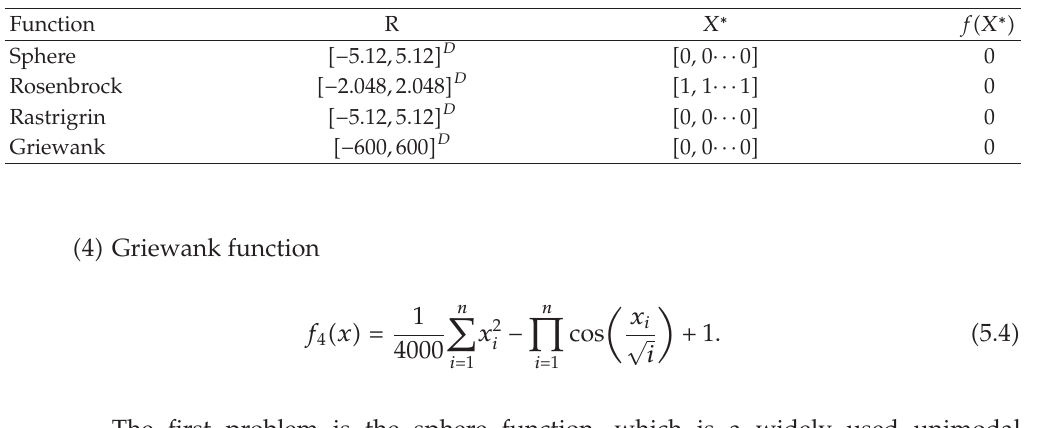
Table 1: Parameters of the test